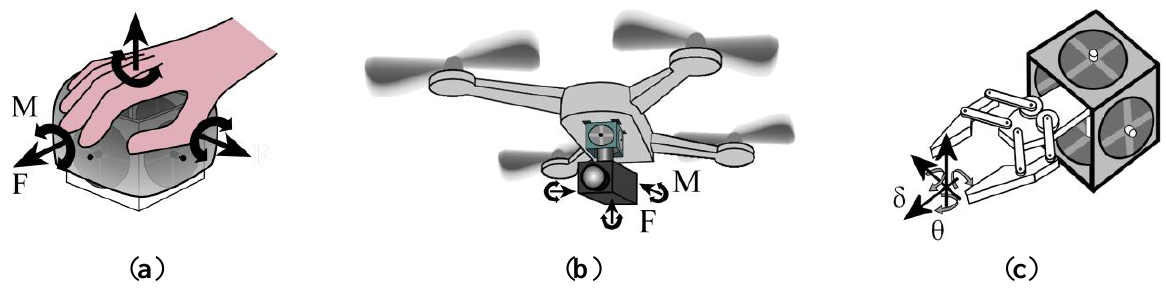
Figure 1. Example applications for the cube dielectric elastomer actuator (DEA) with six degrees of freedom (6-DOF) output: ( a ) lightweight haptic device; ( b ) active vibration stabilisation of camera on a mobile quadrotor robot; ( c ) 6-DOF manipulator (where grasping mechanism is driven by separate 1-DOF actuator inside cube